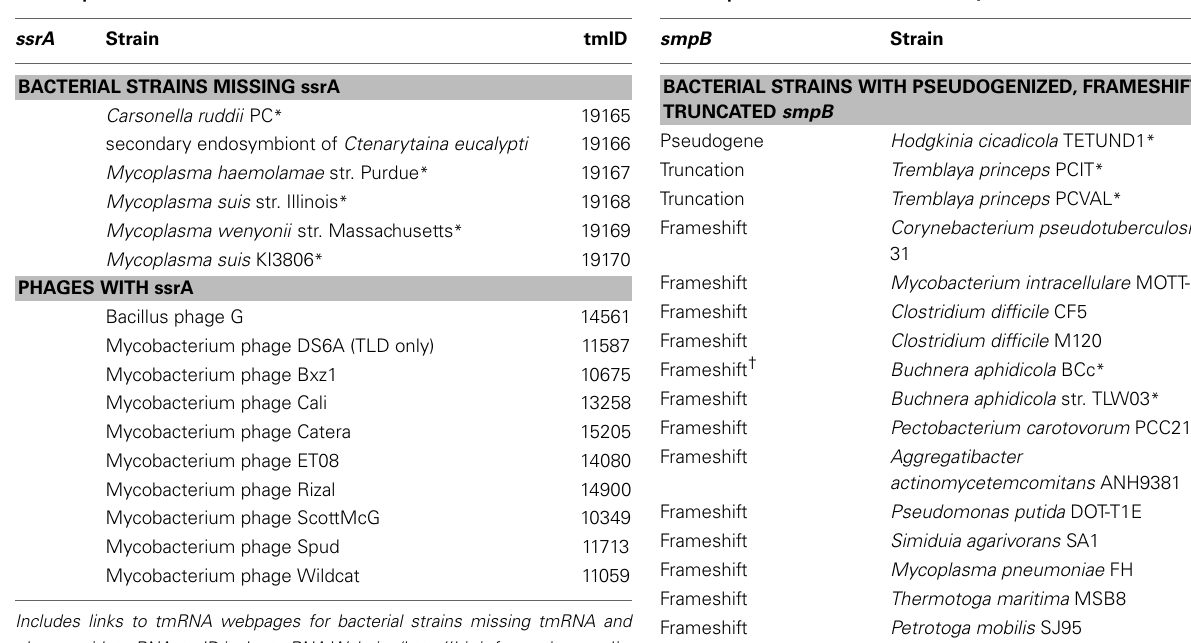
Table 2 | Genomes with unusual ssrA content. Table 3 | Genomes with unusual smpB